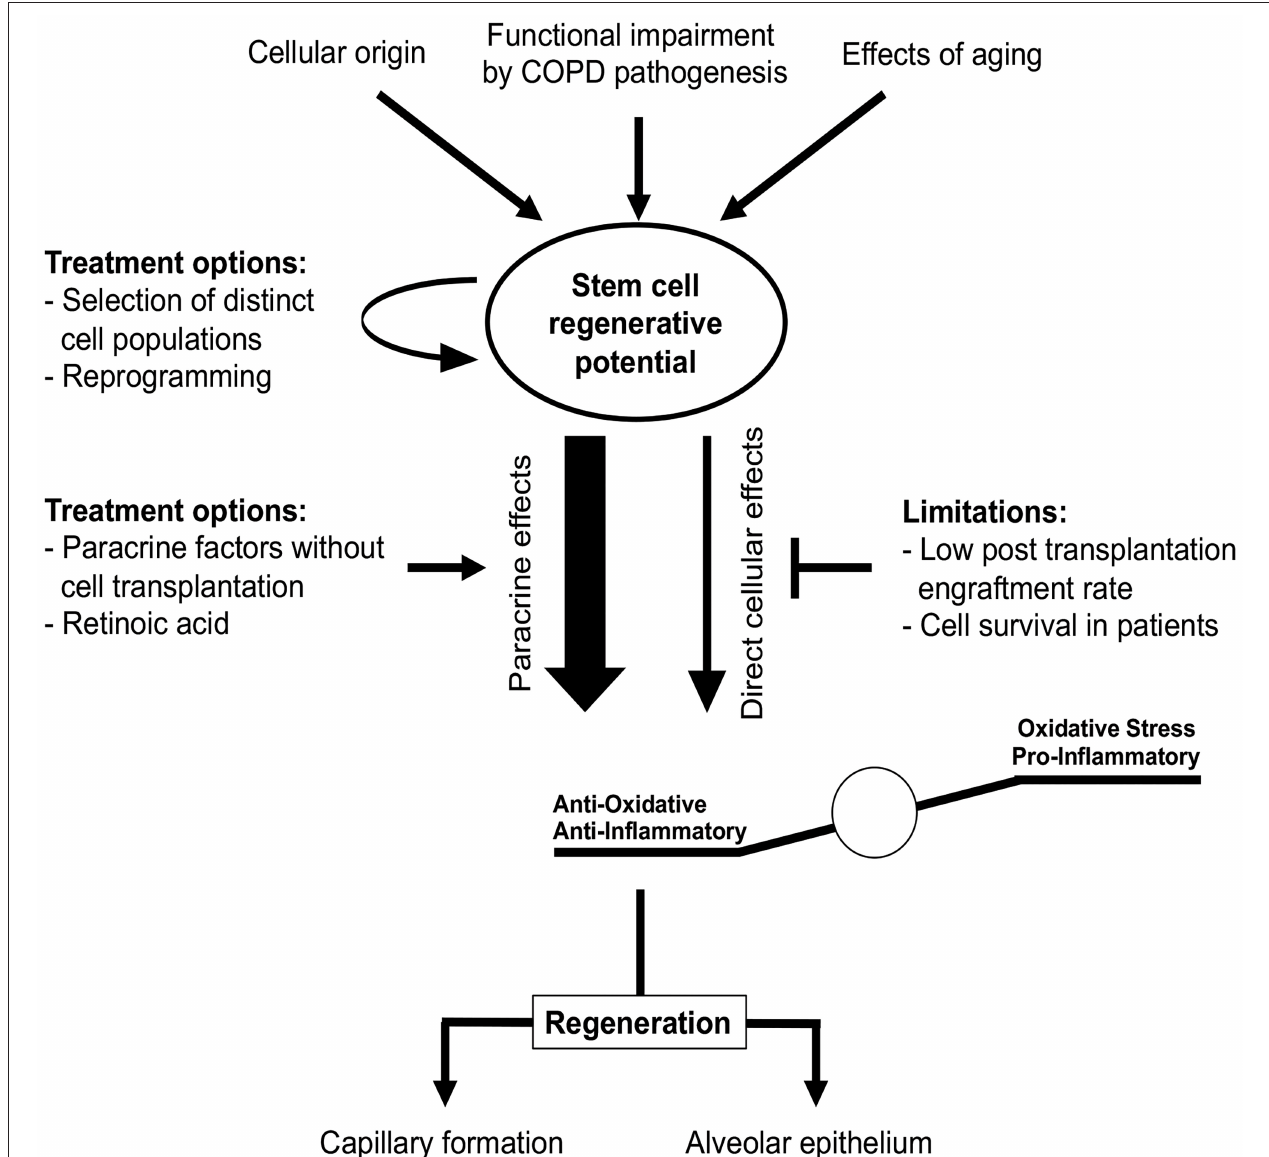
FIGURE 7 | Stem cells in COPD treatment. Stem cell regenerative potential critically depends on cellular origin and can be impaired by different processes, e.g., due to aging or COPD itself. These impairments might be overcome by selection of distinct stem cell sub-populations or cellular reprogramming prior to transplantation. Regenerative potential of stem cells in COPD is rather mediated by paracrine effects reducing oxidative stress and pro-inflammatory stimuli than direct cellular effects, since cell engraftment and survival rates observed in vivo are low. Studies of COPD treatment have to focus not only on the functional regeneration of alveolar epithelium, but also on vascular aspects as both are required for effective